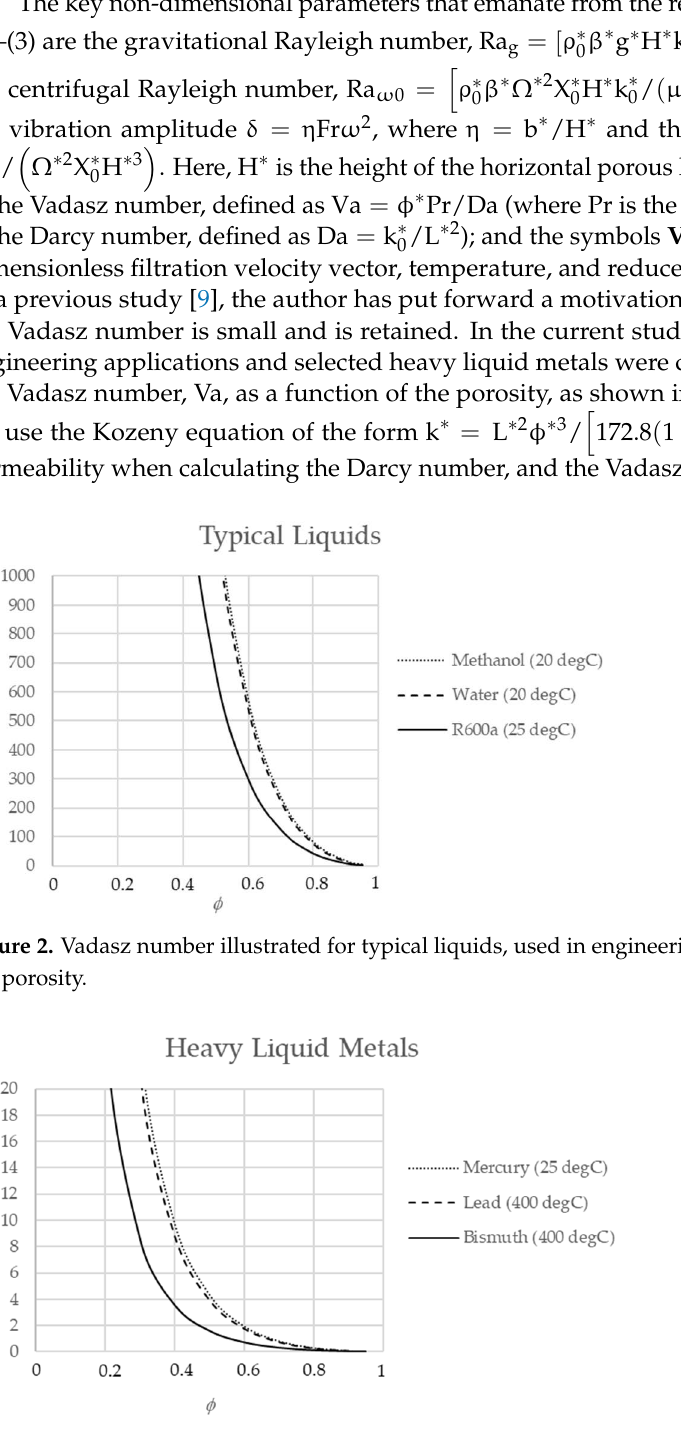
Figure 3. Vadasz number, illustrated for heavy liquid metals. Here, φ is the porosity.